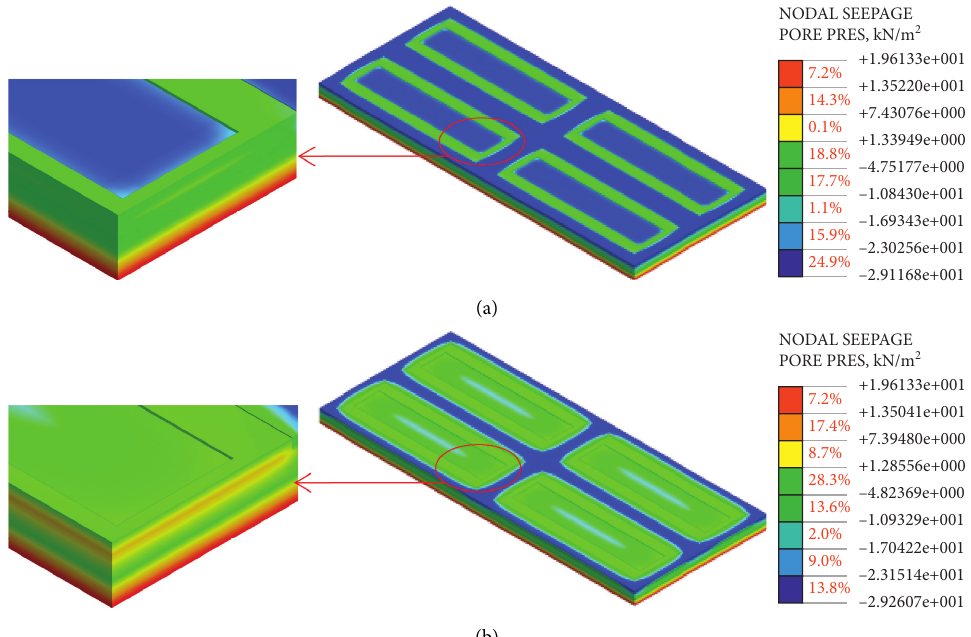
Figure 15: Pore water pressure nephograms of buildings without seepage wells following (a) 10 min and (b) 120min of rainfall in the numerical model (the color of the legend represents the pore water pressure range. The value of the legend represents the pore water pressure value. The red % represents the volume percentage of color legend in the whole numerical model.).